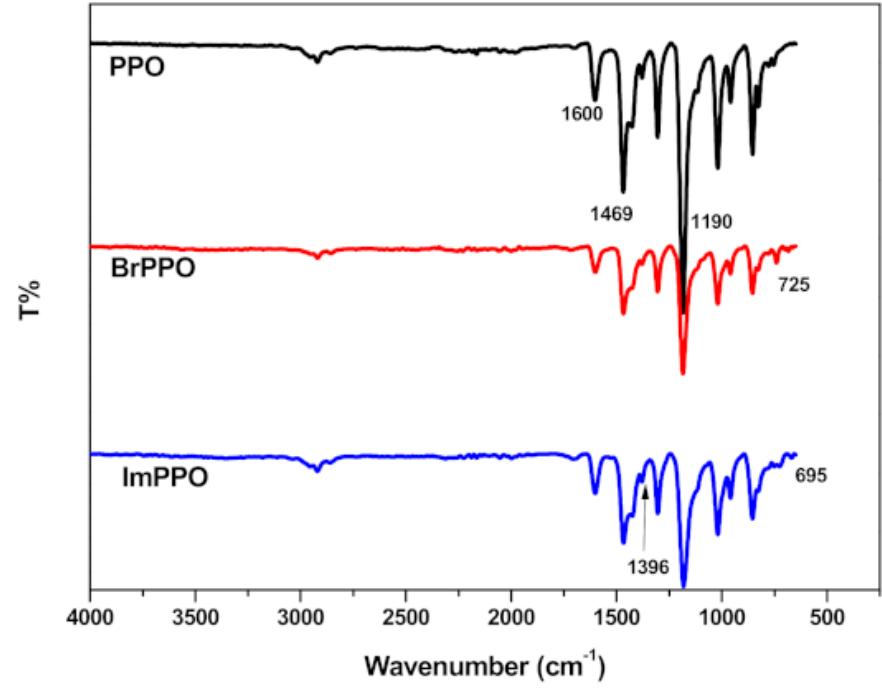
Figure 5. FTIR spectra of PPO, Br-PPO, ImPPO, and